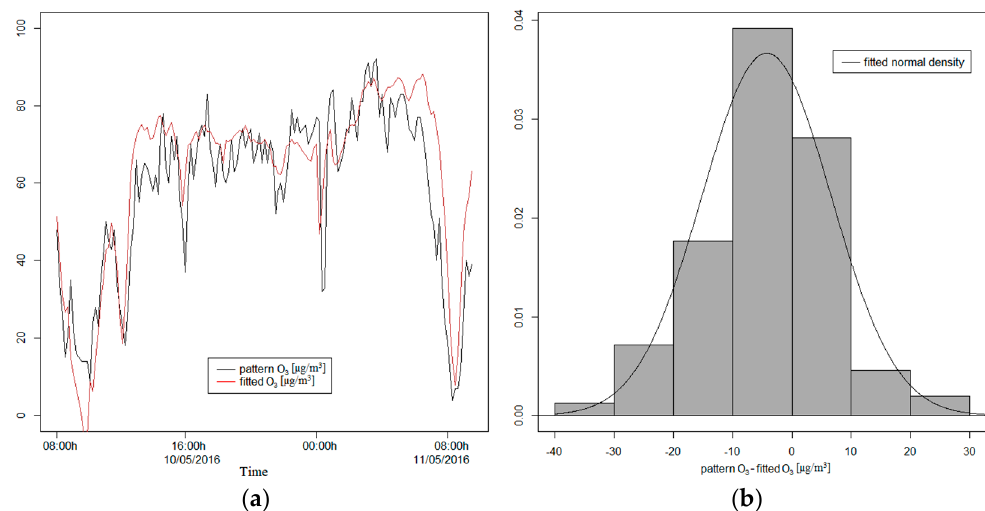
Figure 6. Both graphs with the test dataset. ( a ) The fitted values by the model and the pattern values for ozone; ( b ) the histogram of the net prediction errors of the model.